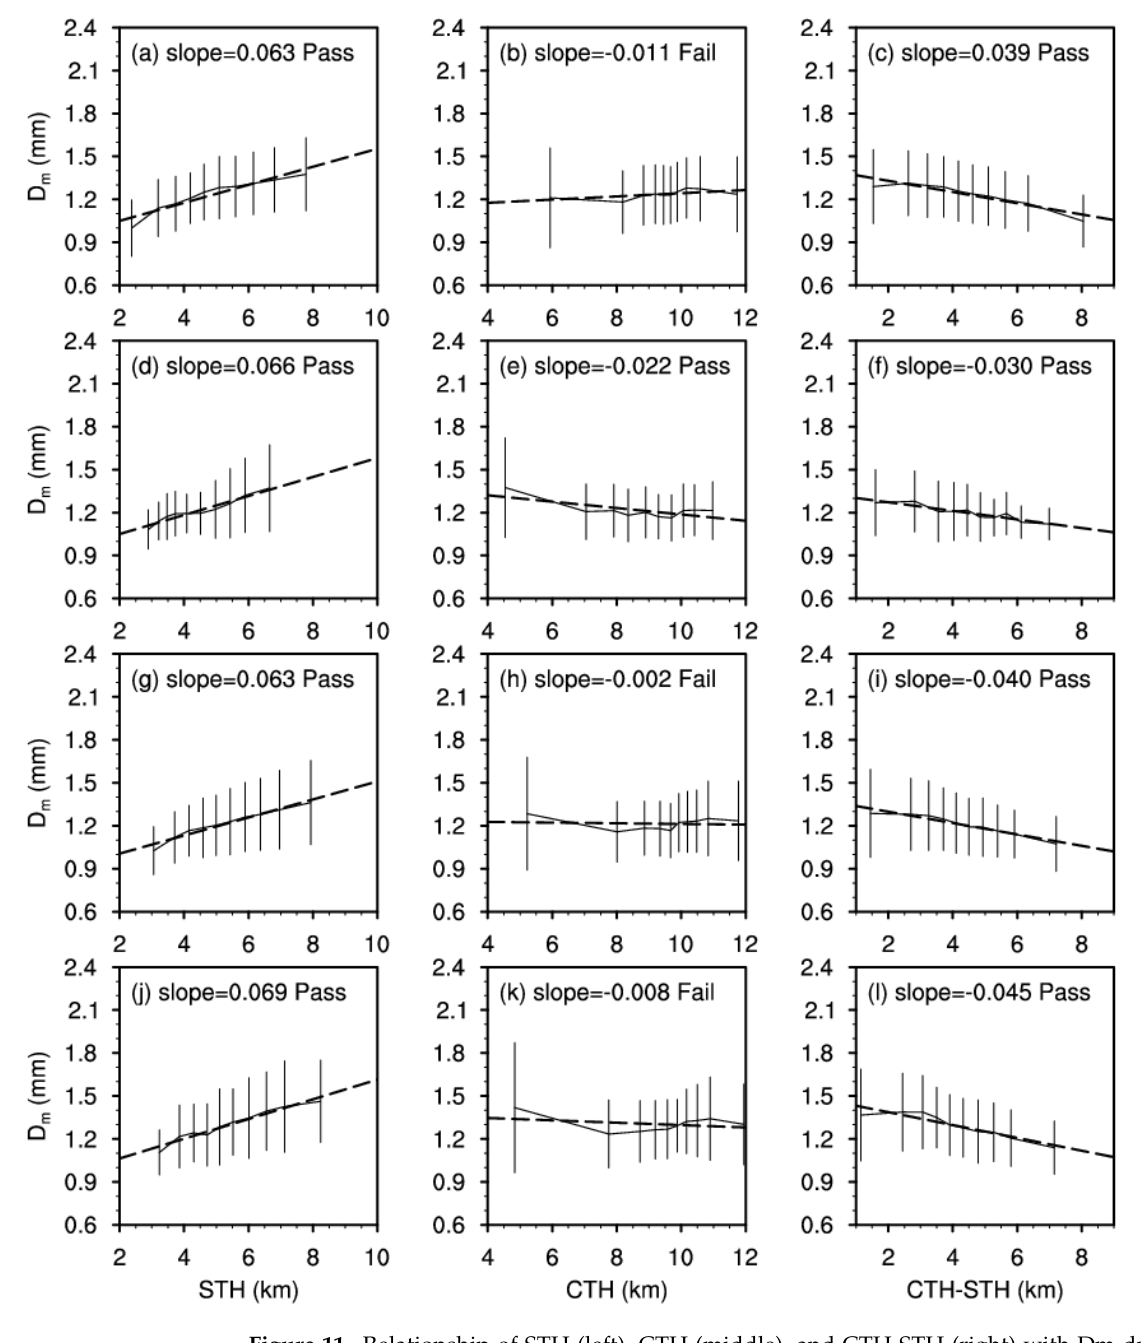
Figure 11. Relationship of STH (left), CTH (middle), and CTH-STH (right) with Dm during the 2020-TC pe-riod. According to the classification shown in Figure 8, the different dominant physical processes under the melting level are represented from top to bottom: ( a – c ) coalescence, ( d – f ) size- sorting or evaporation, ( g – i ) break-up, and ( j – l ) break-up and coalescence balance. Bars represent the standard deviation; the dashed line is the line of best fit for 10 equal-sample points; the panel let-tering of each sub-figure is followed by the slope of the line of best fit and whether it passes the 95% significance